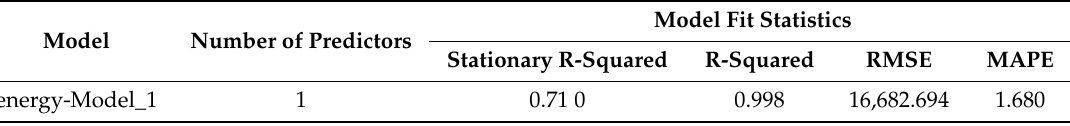
Table 3. The model statistics for